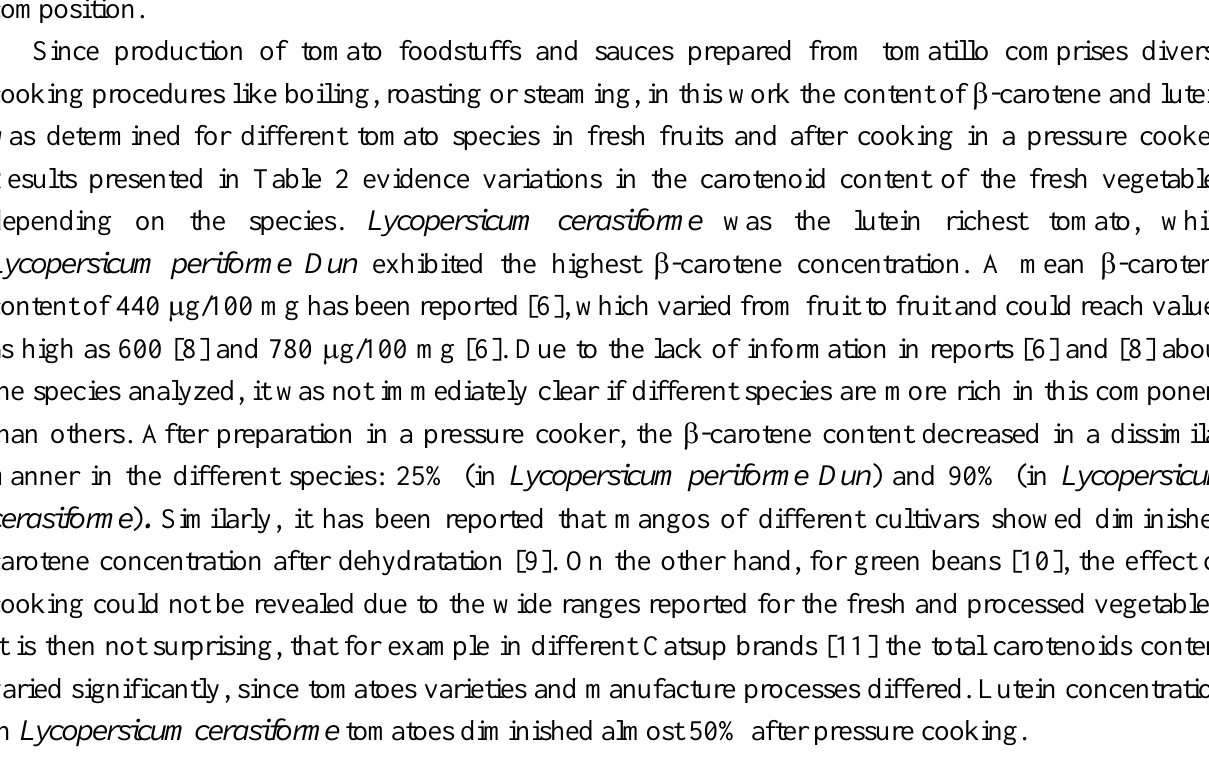
Table 2. Mean carotenoids concentrations in different tomatoes and